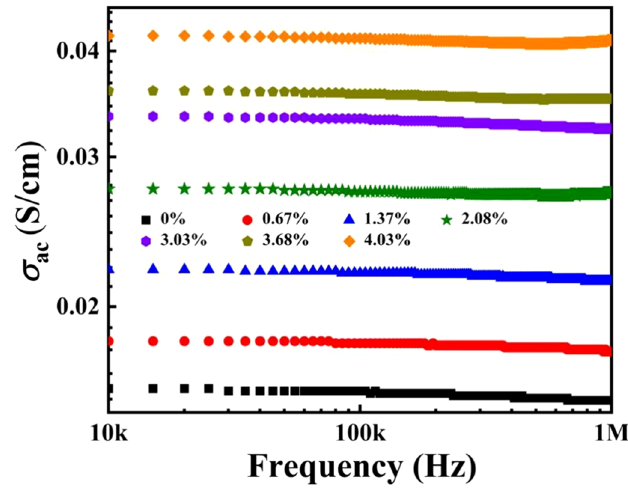
Fig. 4. The AC conductivity spectra of CFS/AgNWs composites with different content of